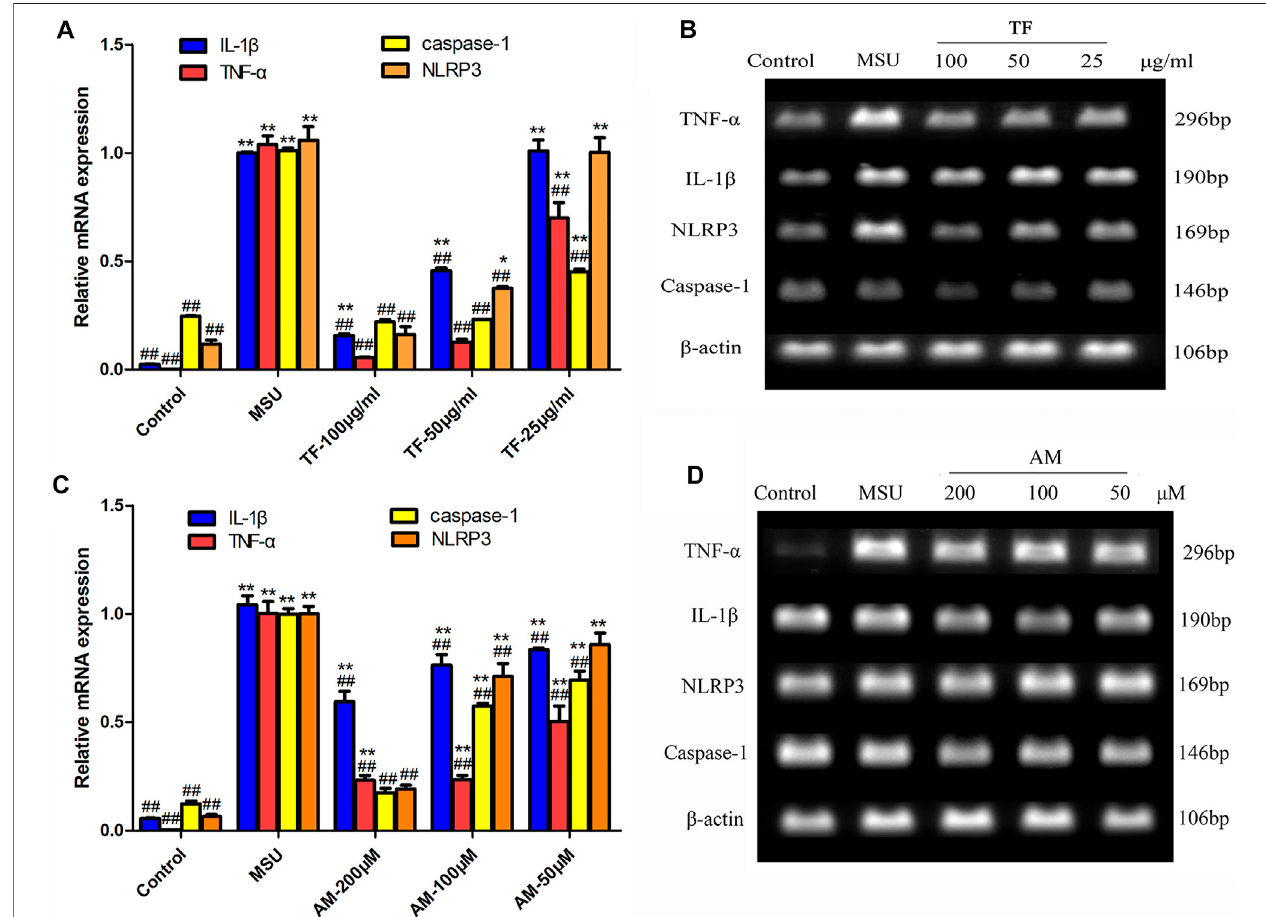
FIGURE 7 | The Effects of TF and AM on mRNA in LPS/MSU-induced THP-1 macrophages. (A, C) The gene expressions of TNF- α , IL-1 β , NLRP3 and caspase-1 mRNA (B, D) The detected bands of gene products. * p < 0.05 and ** p < 0.01, signi fi cantly different the normal control group; # p < 0.05 and ## p < 0.01, signi fi cantly different the LPS/MSU control group. TF, fl avonoid extract; AM, amento fl avone.